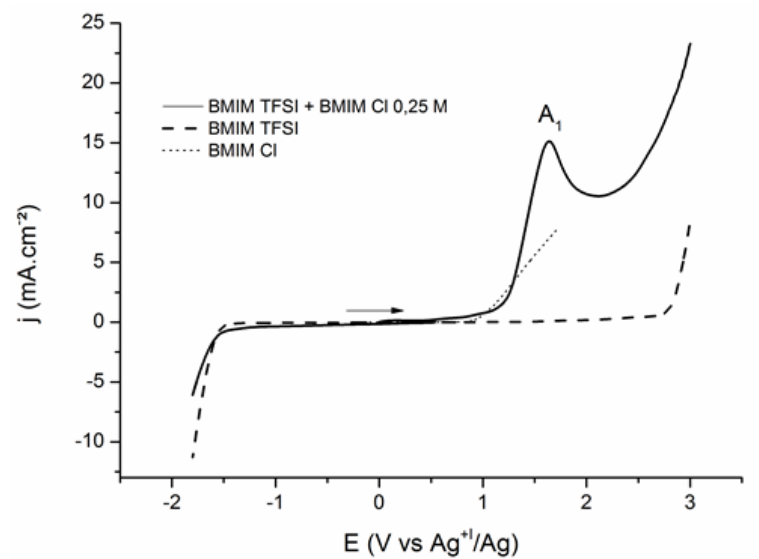
Figure 5. Linear sweep voltammetry on a Pt electrode in various ionic liquid media under inert atmosphere at 100 °C, sweep rate = 20 mV·s − 1 .